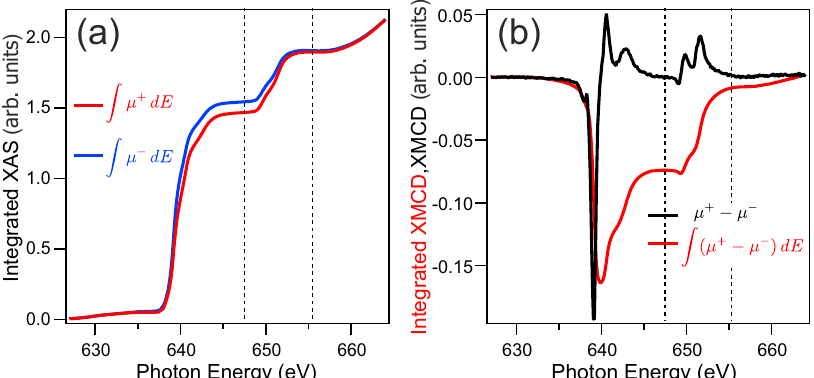
Fig. 3 X-ray magnetic circular dichroism (XMCD) sum rule calculated for MAMn 0.3 Pb 0.7 I 3 . a Integration of X-ray absorption spectroscopy (XAS) L 2,3 edges for ±8 T, at 8.5 K. b XMCD and its corresponding integration. The magnetic fi eld is parallel to the surface plane.